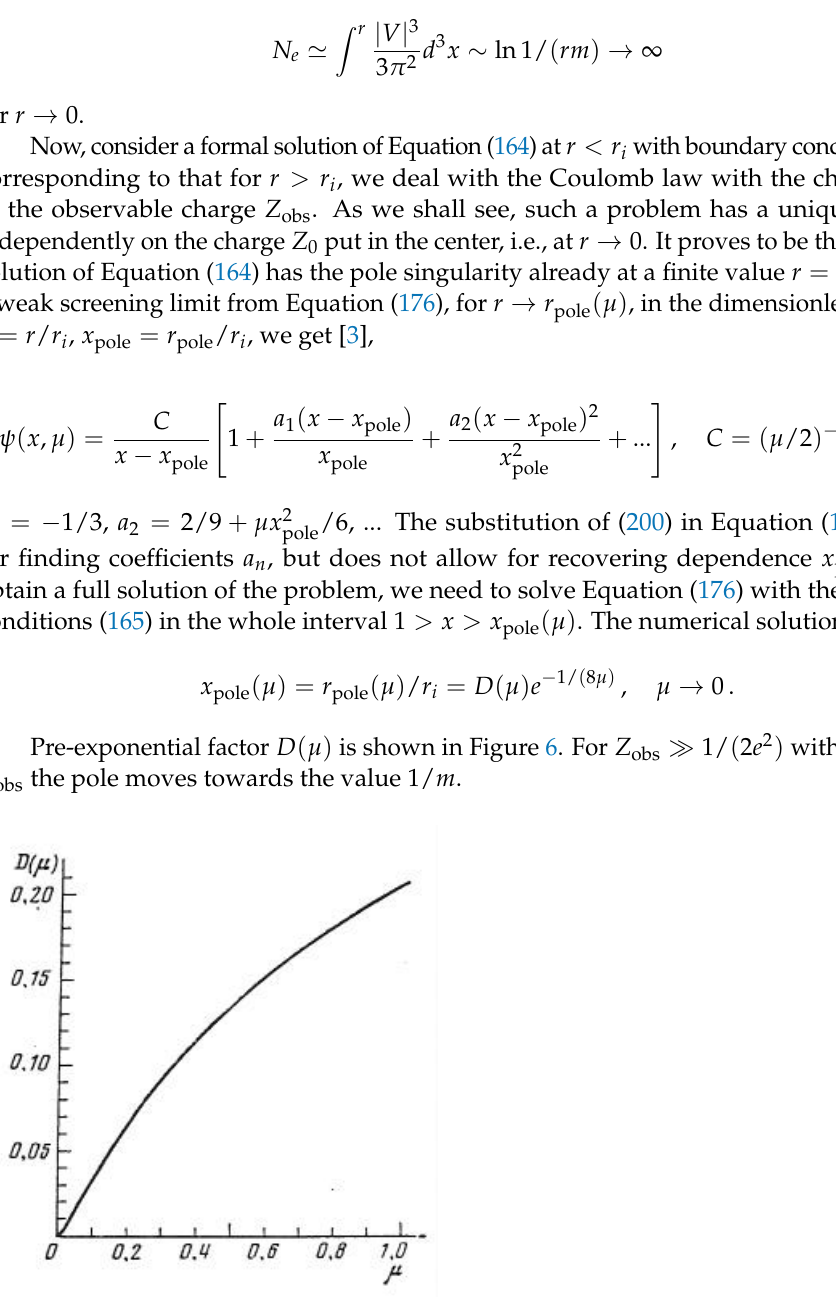
Figure 6. Pre-exponential factor D ( µ ) in Equation (201), cf.